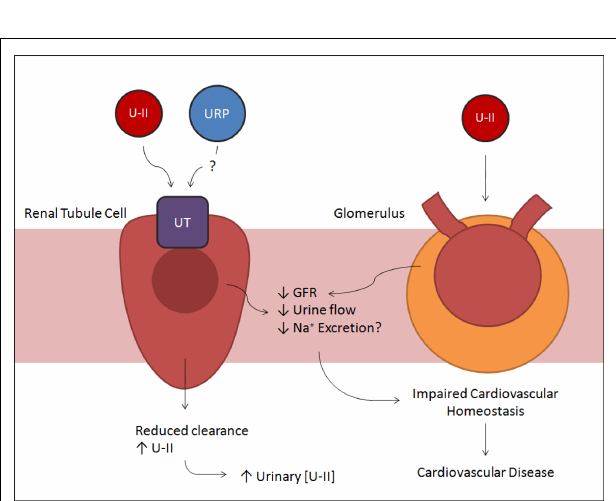
FIGURE 4 | Summary schematic of the effects of UII in the renal tubules and glomerulus. Urotensin and possibly urotensin-related protein binding to UT in renal tubule cells results in decreased urine flow. In addition, UII acting at the glomerulus directly decreases glomerular filtration rate.These effects impair normal cardiovascular homeostasis, increasing blood pressure, and promoting cardiovascular disease.